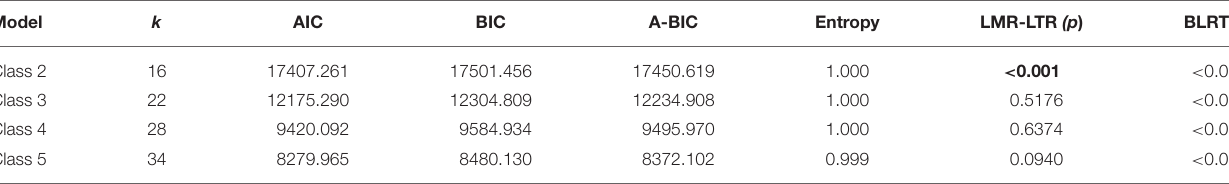
TABLE 3 | Fit indices for the latent profile analysis of 5 items on perceptions and attitudes towards COVID-19. Model